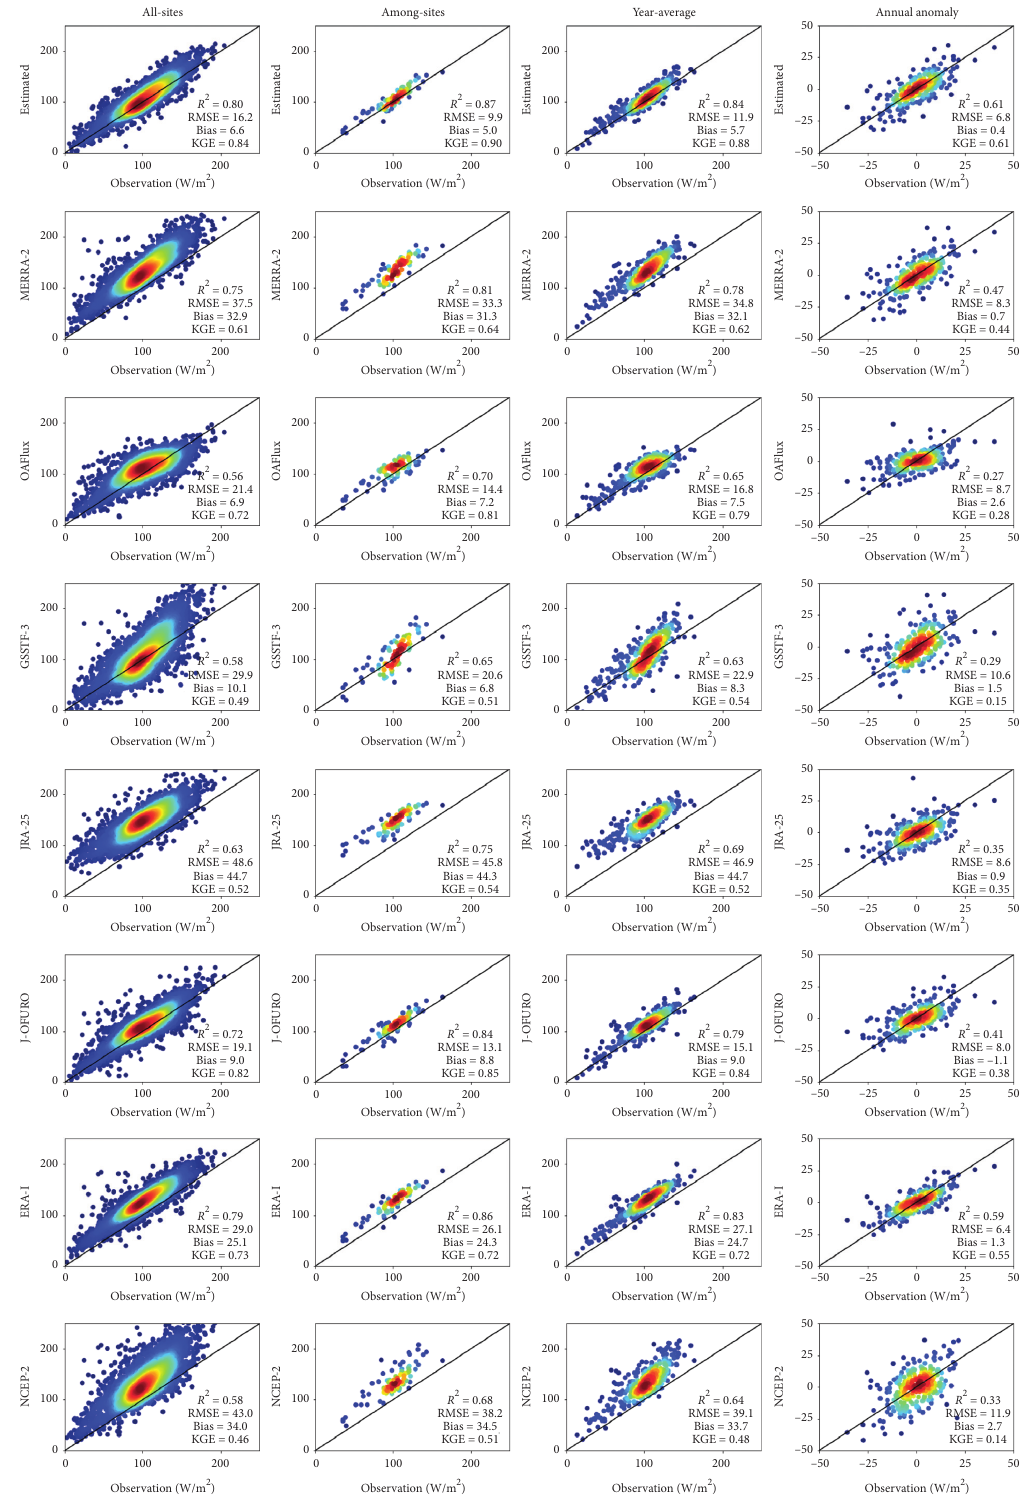
Figure 3: The estimated LHF ( y axis, units: W/m 2 ) from different products versus observed LHF ( x axis, units: W/m 2 ) from buoy sites for among-site variability, year-average LHF, and annual LHF